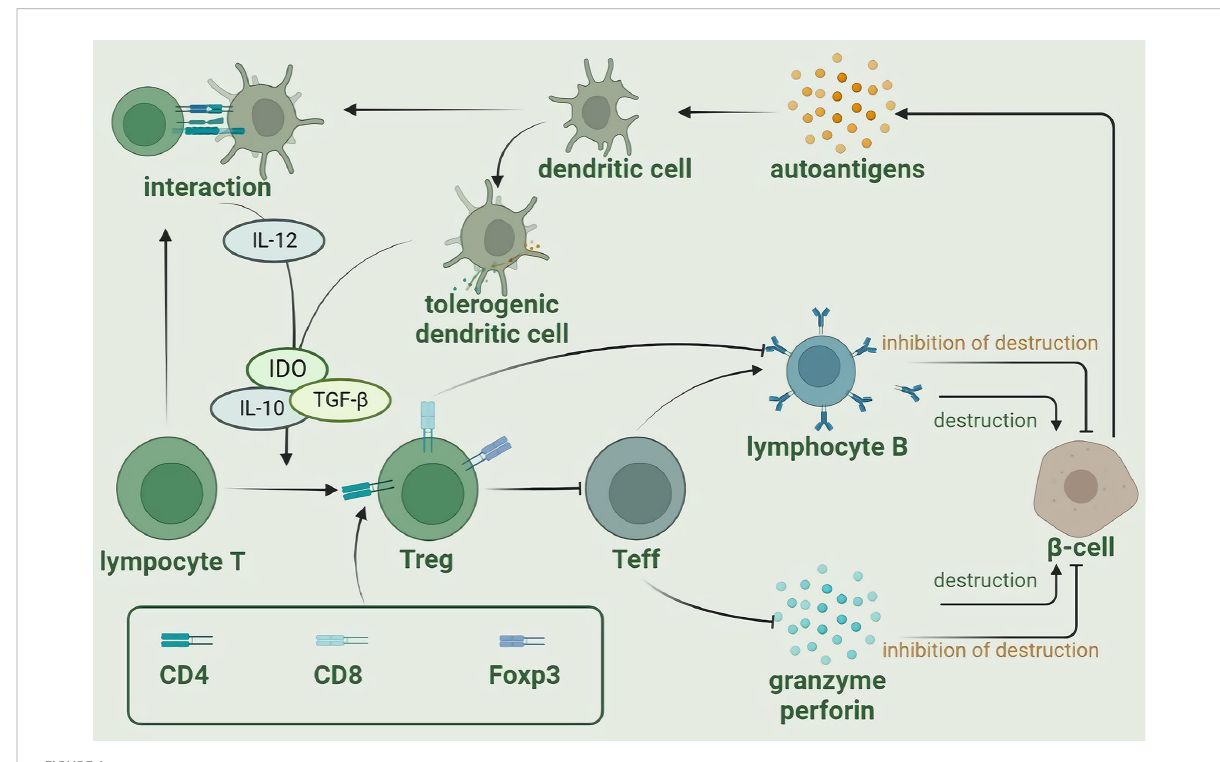
FIGURE 1 The regulatory roles of T cells in autoimmune reaction (created with